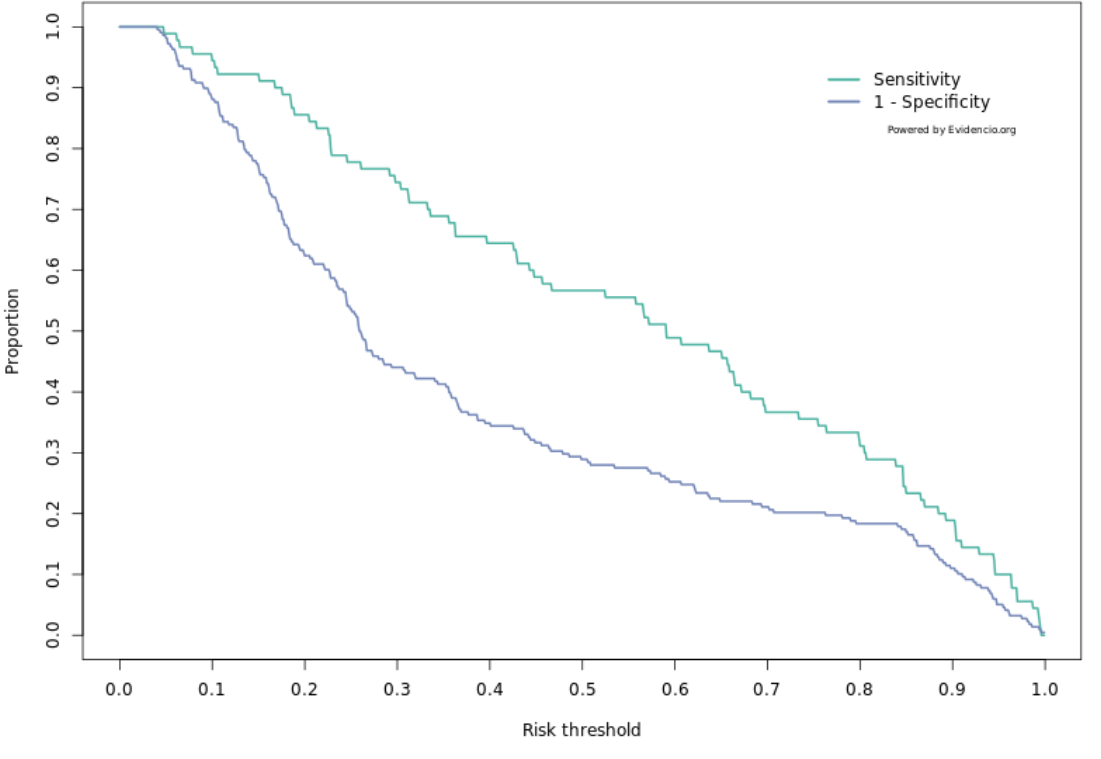
Figure 3. Classification plot representing the relationship between sensitivity and 1-specificity.